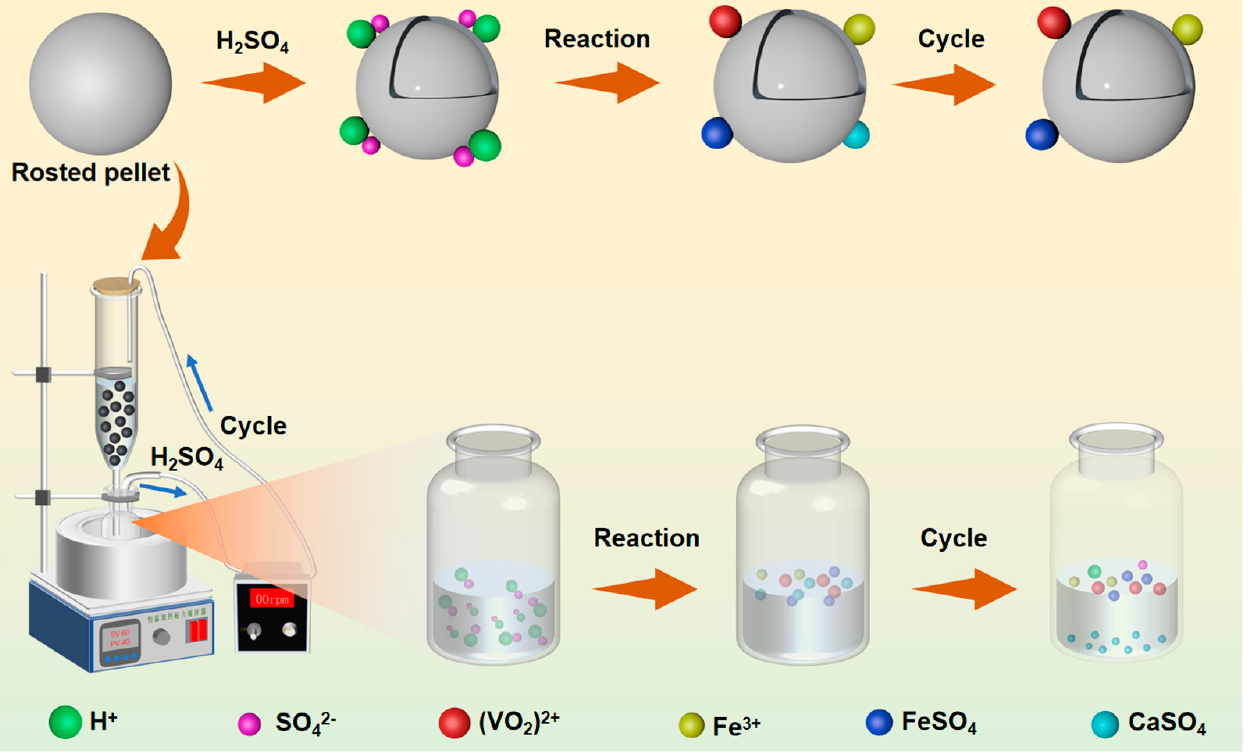
Figure 1. Experimental reaction mechanism diagram.